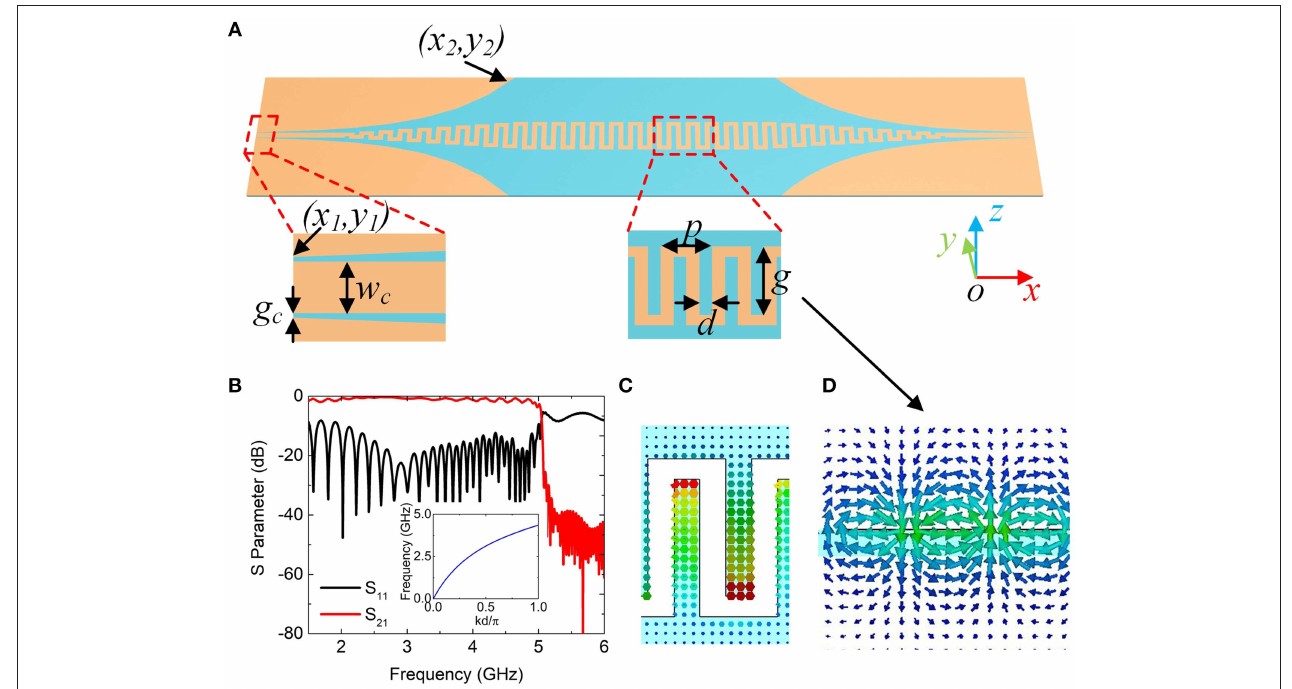
FIGURE 3 | (A) Proposed SSPPs waveguide composed of S-shaped unit cells connected to two CPW lines through the mode converter. The mode converter is composed of unit cells with gradually increasing groove depth and the flared ground plane. (B) Simulated transmission and reflection from the designed SSPPs waveguide solved by CST Microwave Studio. Inset: dispersion curves of the SSPPs cell calculated by eigen-mode; Magnetic field distributions at two cutting planes z = 0 (C) and y = 0 (D)